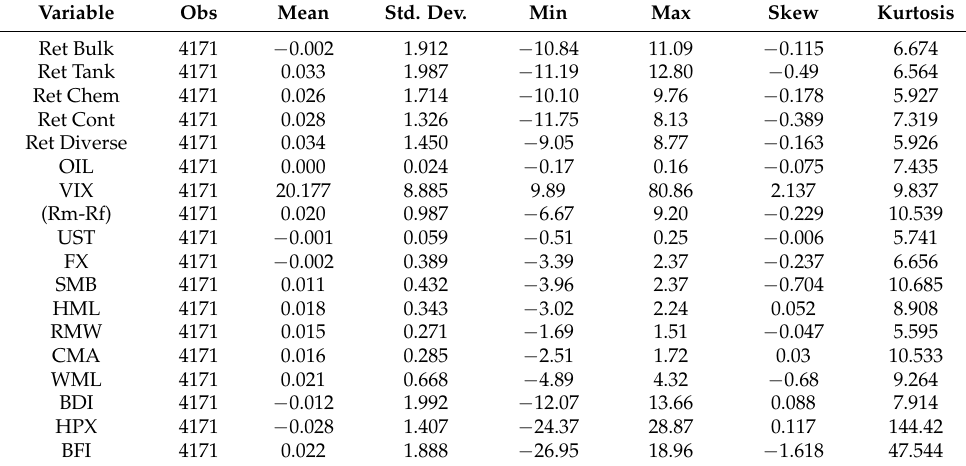
Table 1. Descriptive statistics.